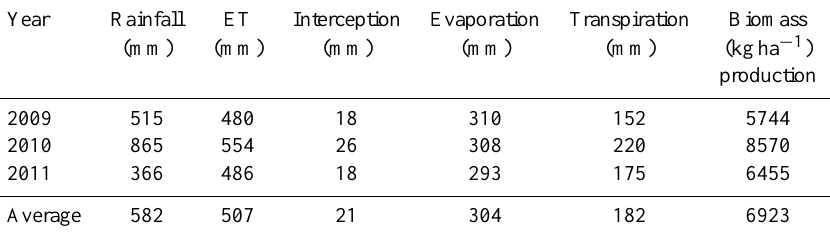
Table 5. Annual total precipitation and ET in the Awash Basin averaged over the 3yr: 2009, 2010 and 2011. Rainfall and ET data are based on remote sensing. The actual evapotranspiration is partitioned into evaporation, transpiration and interception following ETLook